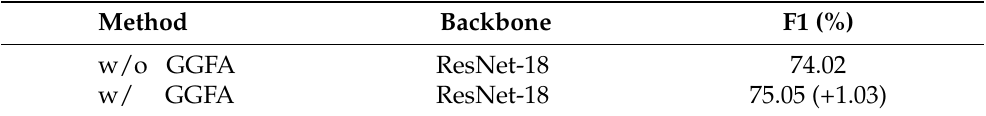
Table 6. The effectiveness of GGFA.